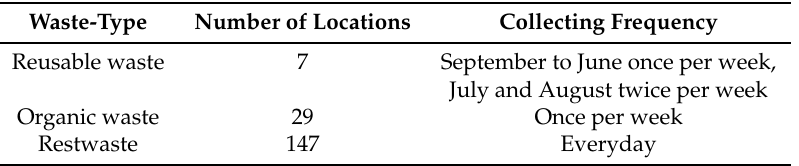
Table 1. Three problems analyzed.